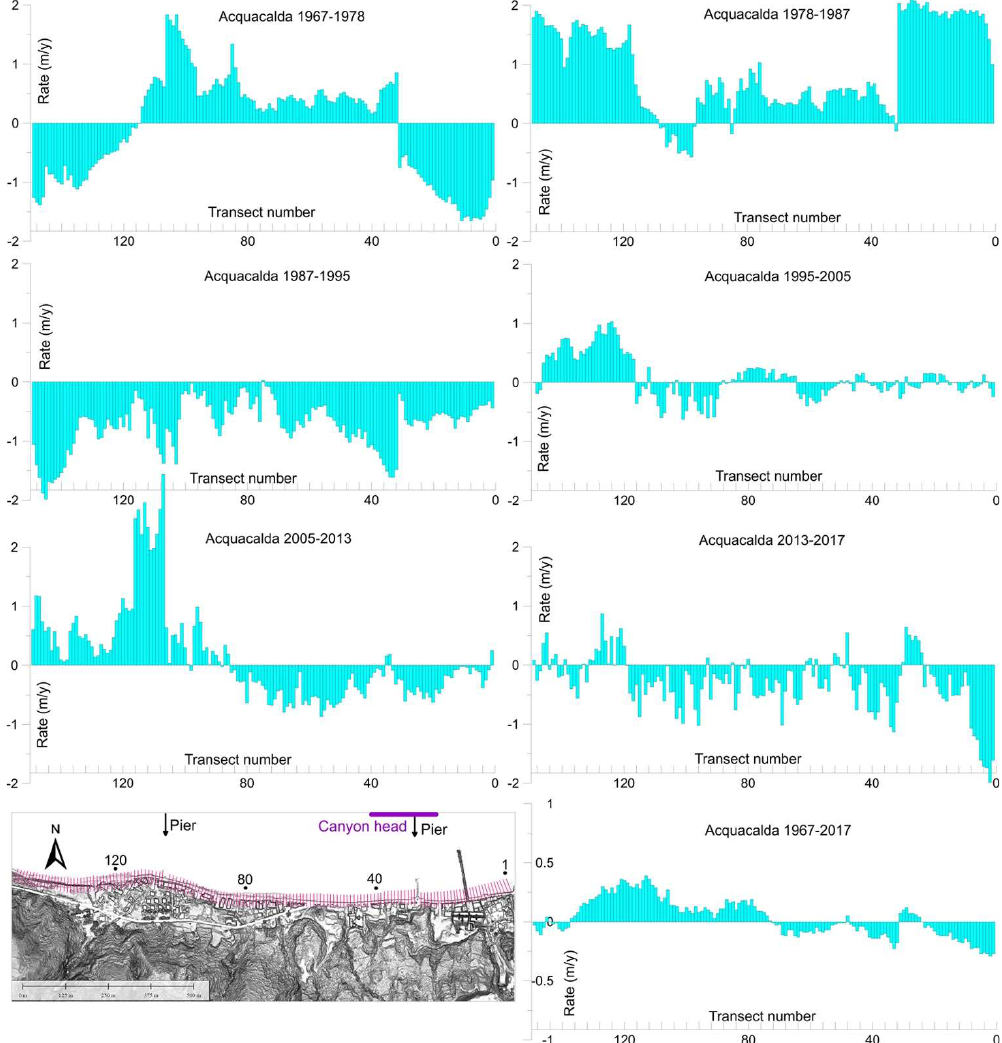
Figure A2. Rate of shoreline displacement for Acquacalda beach, estimated by means of DSAS along transects spaced 10 m for the different time intervals and for the overall time span of the analysis.